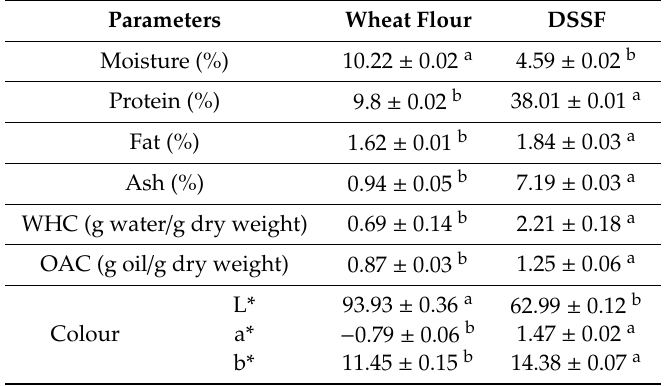
Table 1. Physical and chemical properties of defatted sunflower seed flour and wheat